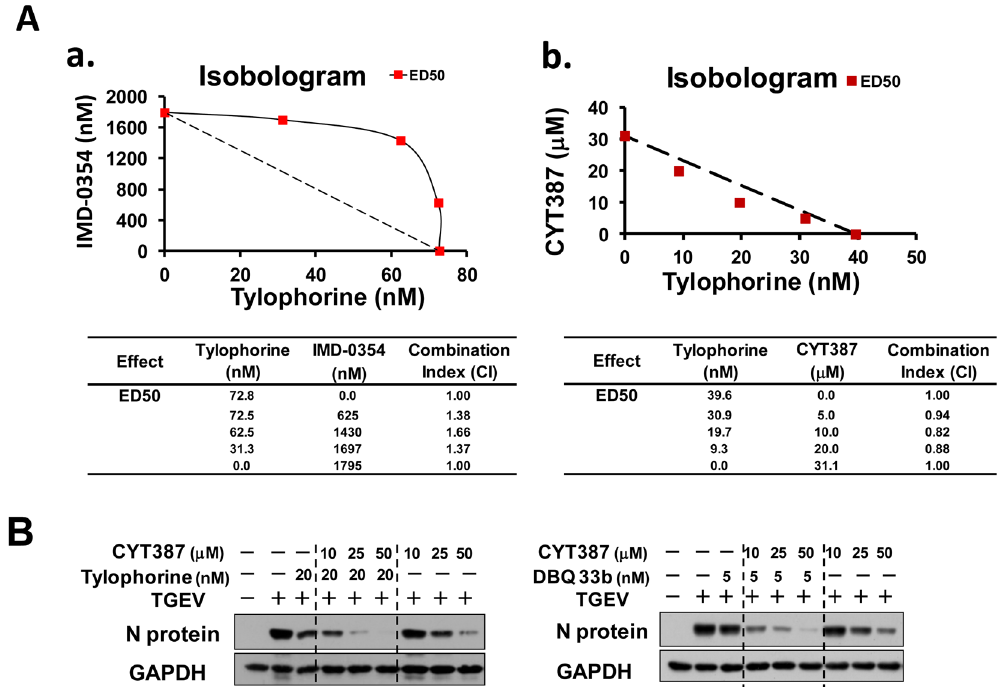
Figure 3. Differential combinatory effects of tylophorine with NF- κ B inhibitors. ( A ) Tylophorine antagonized IMD-0354 but worked in an additive manner with CYT387 for the TGEV inhibition. (a) Tylophorine and IMD- 0354 exerted antagonistic effect in inhibiting TGEV replication. (b) Tylophorine and JAK inhibitor CYT387 inhibited TGEV activity by an additive manner. All the ST cells were treated with vehicle DMSO, tylophorine, IMD-0354, CYT387, or the combination of tylophorine with IMD-0354 or CYT387 for 1 h prior to TGEV infection and detected by immunofluorescence staining at 6 h.p.i. Drug combination tests were monitored by IFA as described in Materials and Methods. TGEV infected ST cells showed a poor adherence property in the presence of CYT387 in 96-well culture plates but exhibited a much better adherence property in 24-well culture plates. Therefore, the combination tests for tylophorine and IMD-0354 were performed in 96-well culture plates and for tylophorine and CYT387 in 24-well culture plates. Isobologram plots of effective dose ED 50 are shown at upper panels. The combination index (CI) values at ED 50 were calculated using Calcusyn software